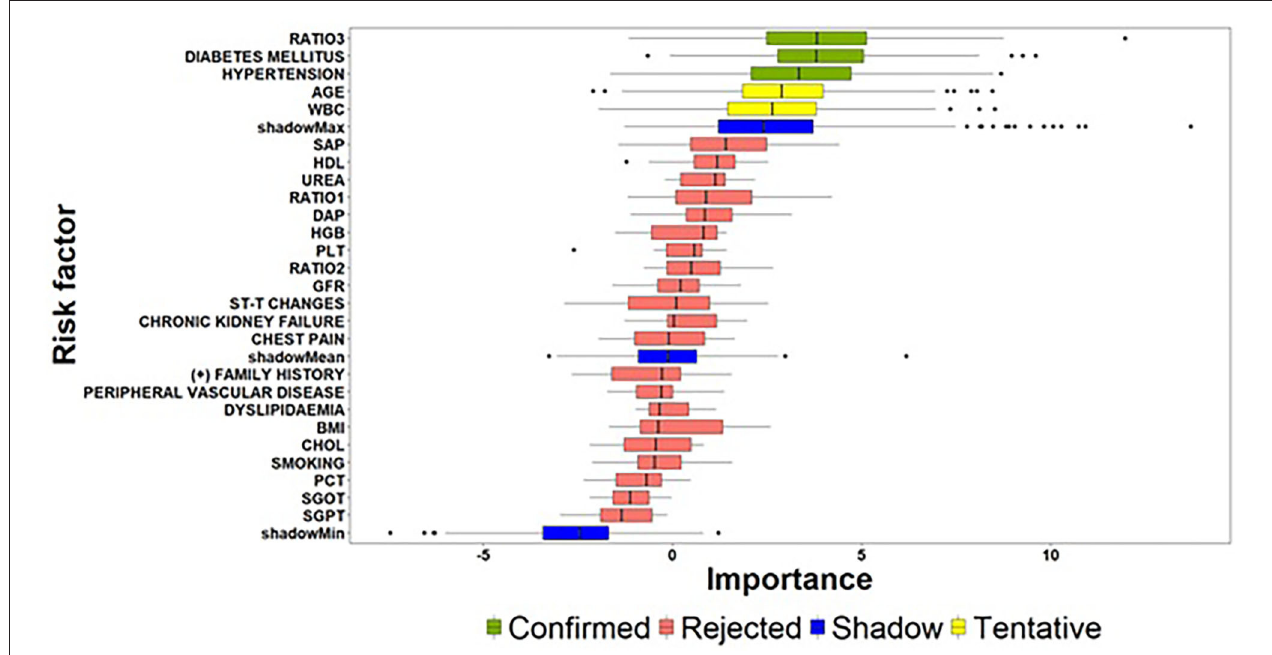
FIGURE 3 | Importance of features extracted by the Boruta algorithm (zero-part) (the abbreviations of the risk-factors can be found in Table 4 ) [Ratio 1: Monocyte − to − HDL − cholesterol ratio ; Ratio 2: Lymphocyte − to − monocyte ratio ; Ratio 3: Atherogenic Index of Plasma levels (log (cid:16) TG